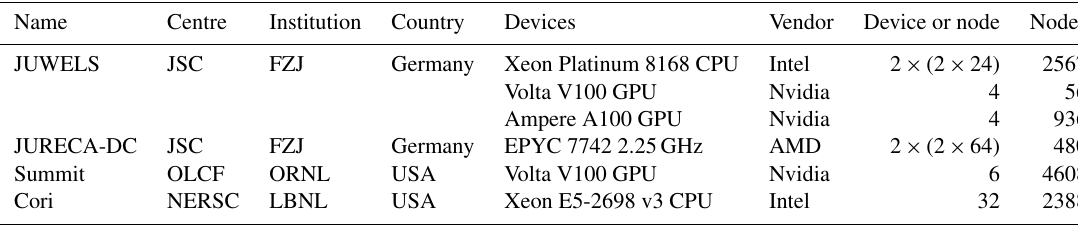
Table 4. HPC systems in which SERGHEI-SWE has been tested.